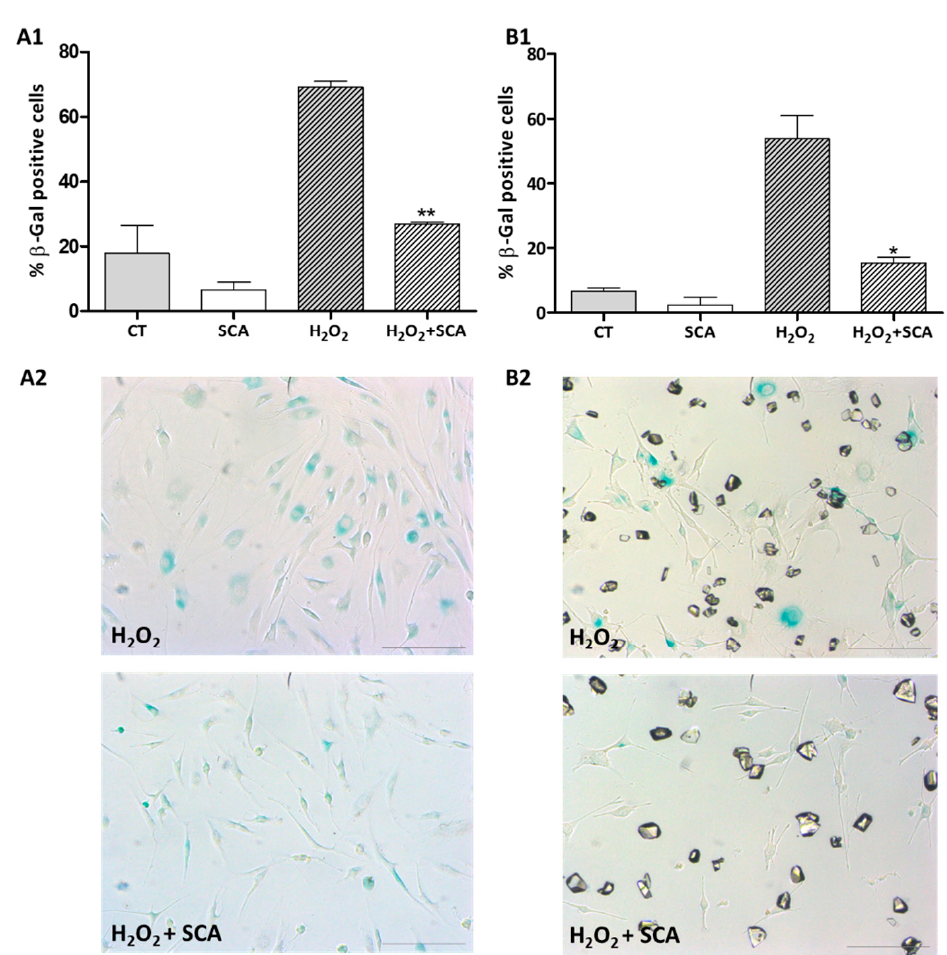
Figure 1. Determination of senescence, β -galactosidase staining. ( A1 , B1 ) Percentage of β -galactosidase-positive cells at different conditions (H 2 O 2 vs. H 2 O 2 + SCA ® ** p < 0.005, * p < 0.05; H 2 O 2 vs. C * p < 0.05). ( A2 , B2 ) Representative images of β -galactosidase blue staining. A column corresponds to fibroblasts, and B column corresponds to B16-F10 cells. (C: Control Cells; SCA ® : control cells treated with SCA ® , H 2 O 2 : Aged control cells, H 2 O 2 + SCA ® : aged cells treated with SCA ® ). Scale bars: 200 µm.